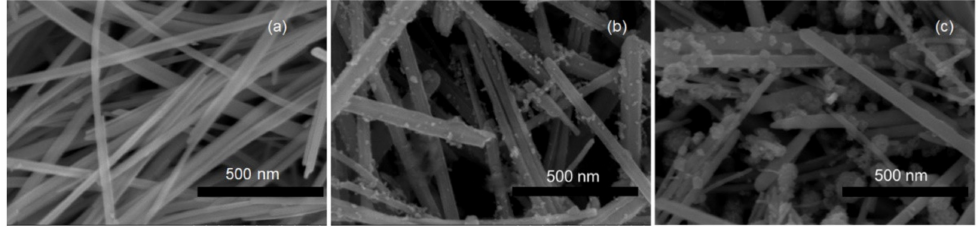
Figure 1. Morphologies of ZnO ( a ), Ag-ZnO ( b ), and CuO-Ag-ZnO ( c )